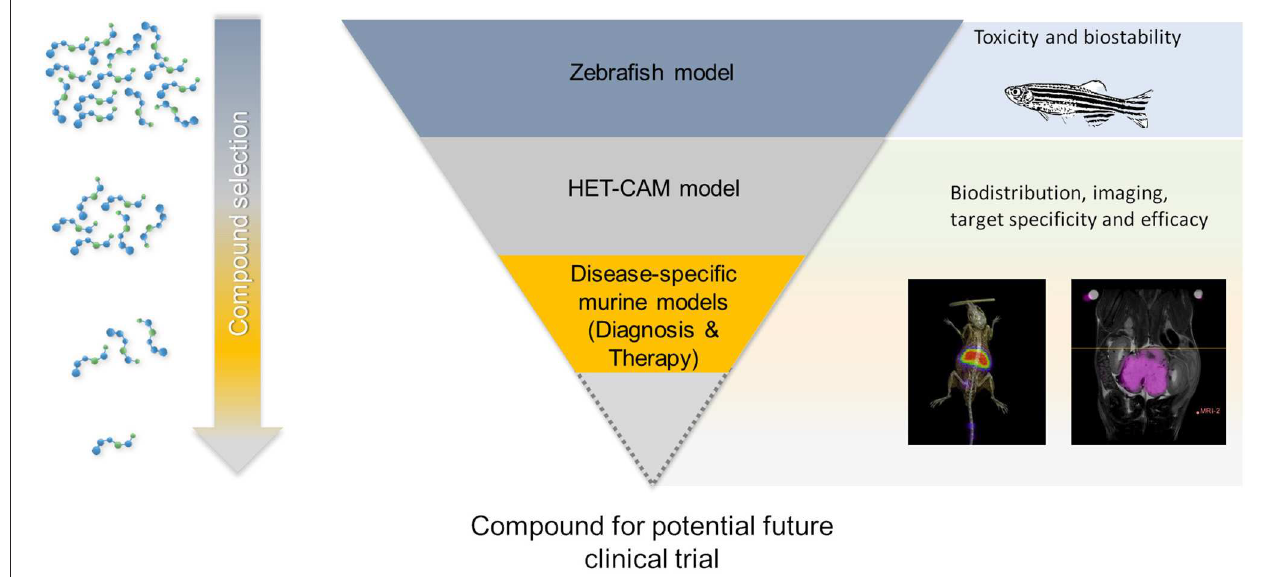
FIGURE 12 | Potential role of PET-MRI imaging in the HET-CAM model within new drug